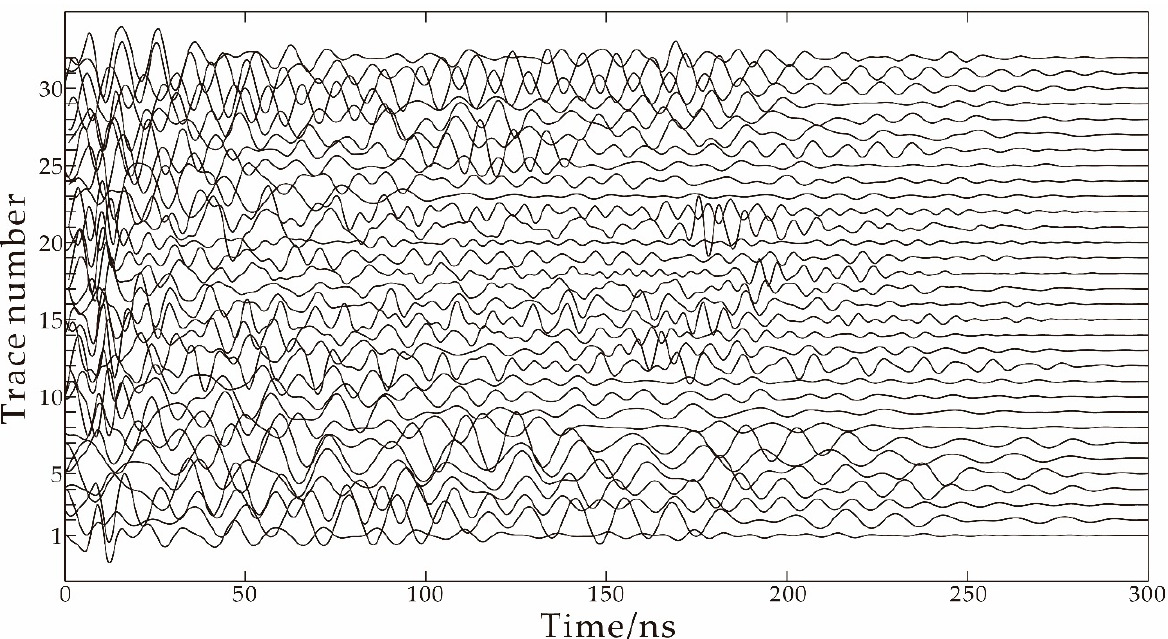
Figure 10. Waveform comparison chart of 32 source wavelets after amplitude normalization.